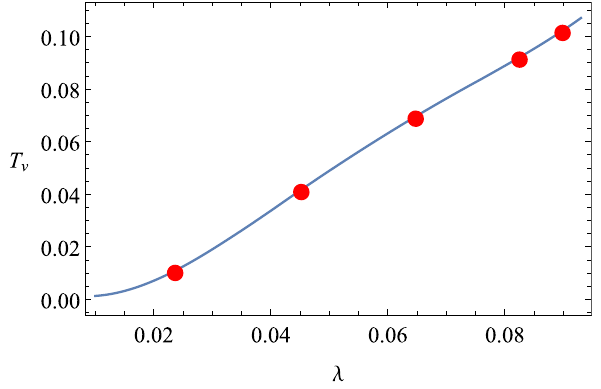
zerotemperatureandzerothermalentropy.Thedashedcurvesrepresent the EGB black hole, while the solid ones represent the modified hairy black holes